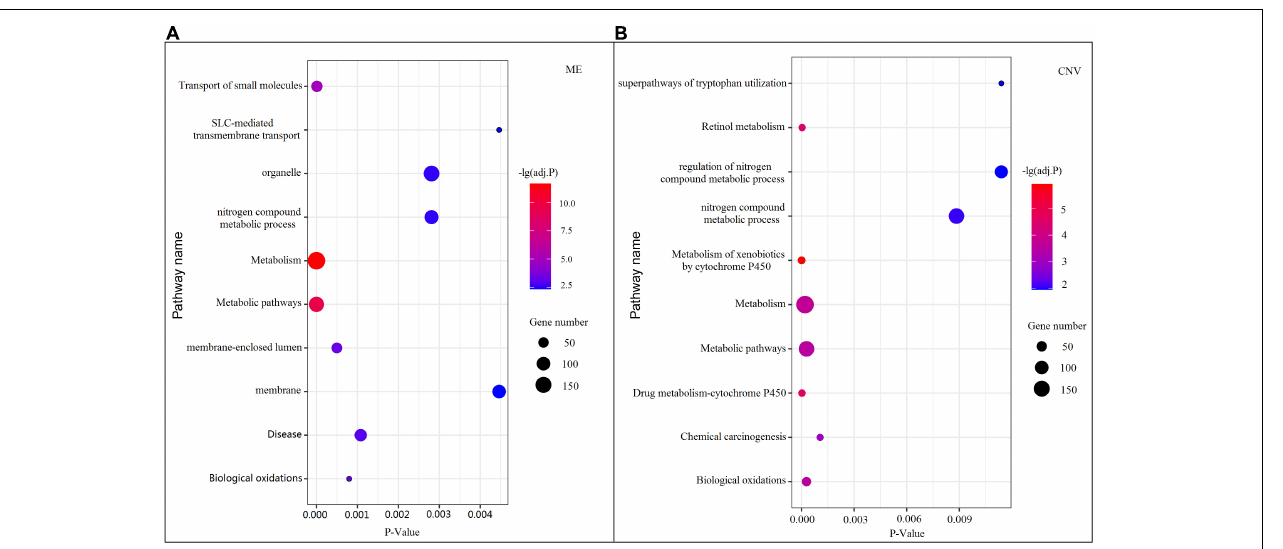
FIGURE 5 | Top 10 pathways enriched in ME and CNV core modules identified by the NMFNA. (A) Represents pathways enriched in the ME core module and (B) represents pathways enriched in the CNV core